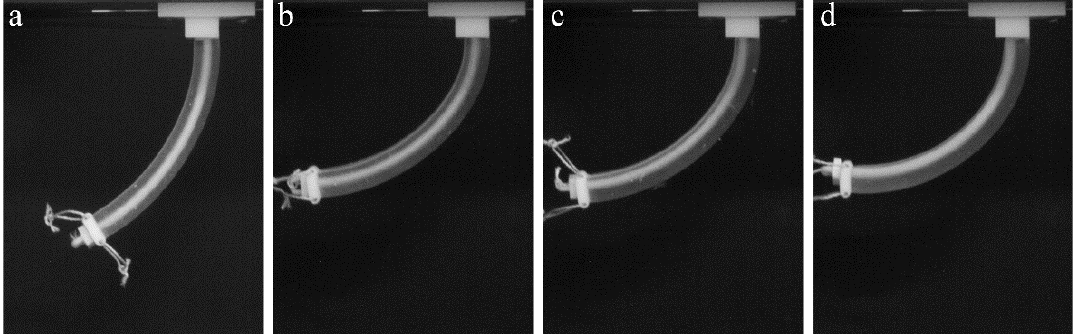
Figure 5. Experimental snapshots for TangoPlus actuators with central channel ( a ) and the channel shifted 1 ( b ), 2 ( c ), and 3 mm ( d ) from the central position. The deformed shape corresponds to a cable retraction length of 16 mm.